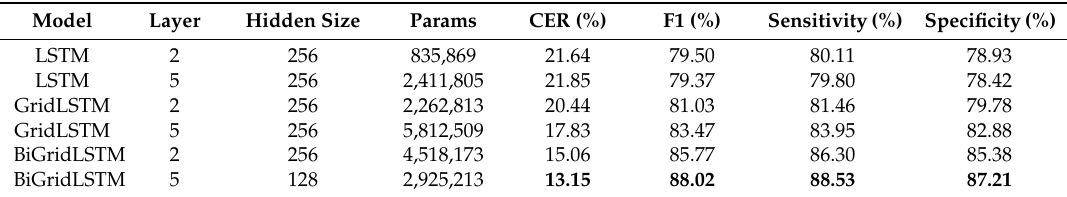
Table 3. CER comparison of deeper models and baseline. The bold data in table indicates the minimum CER and highest sensitivity, specificity, and F1 in the experiment.